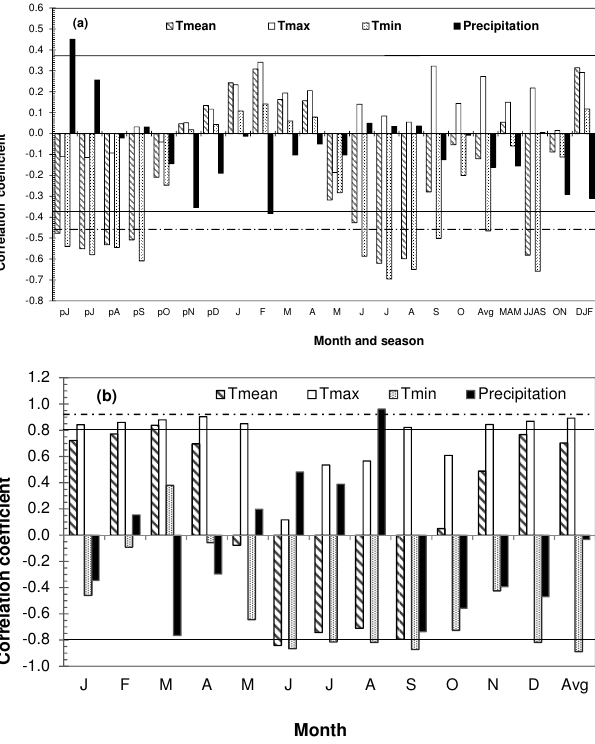
Figure 6. Relationship between the Abies spectabilis ’ radial growth with climate data (monthly mean, maximum, minimum, seasonal average temperature, and monthly and seasonal sum of precipita- tion) (a) , and relationship between regeneration A. spectabilis with monthly climate (b) ; the black horizontal line indicates a signifi- cant correlation at the 95% confidence limit for a two-tailed test and dashed horizontal line indicates a significant correlation at the 99% confidence limit for a two-tailed test. (a) shows the response of radial growth to the monthly climate of June in the previous year to October of the current year as well as seasonal averages. ON and DJF are the mean temperature and the sum of precipitation year December to the current year February, respectively. For cli- matic influence on the regeneration of the A. spectabilis a climatic window of 12months of current years as well as annual average of temperature or annual sum of precipitation are